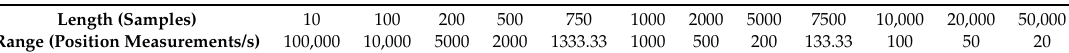
Table 3. Signal integration time and range of position measurements per second used in the simulation. Length